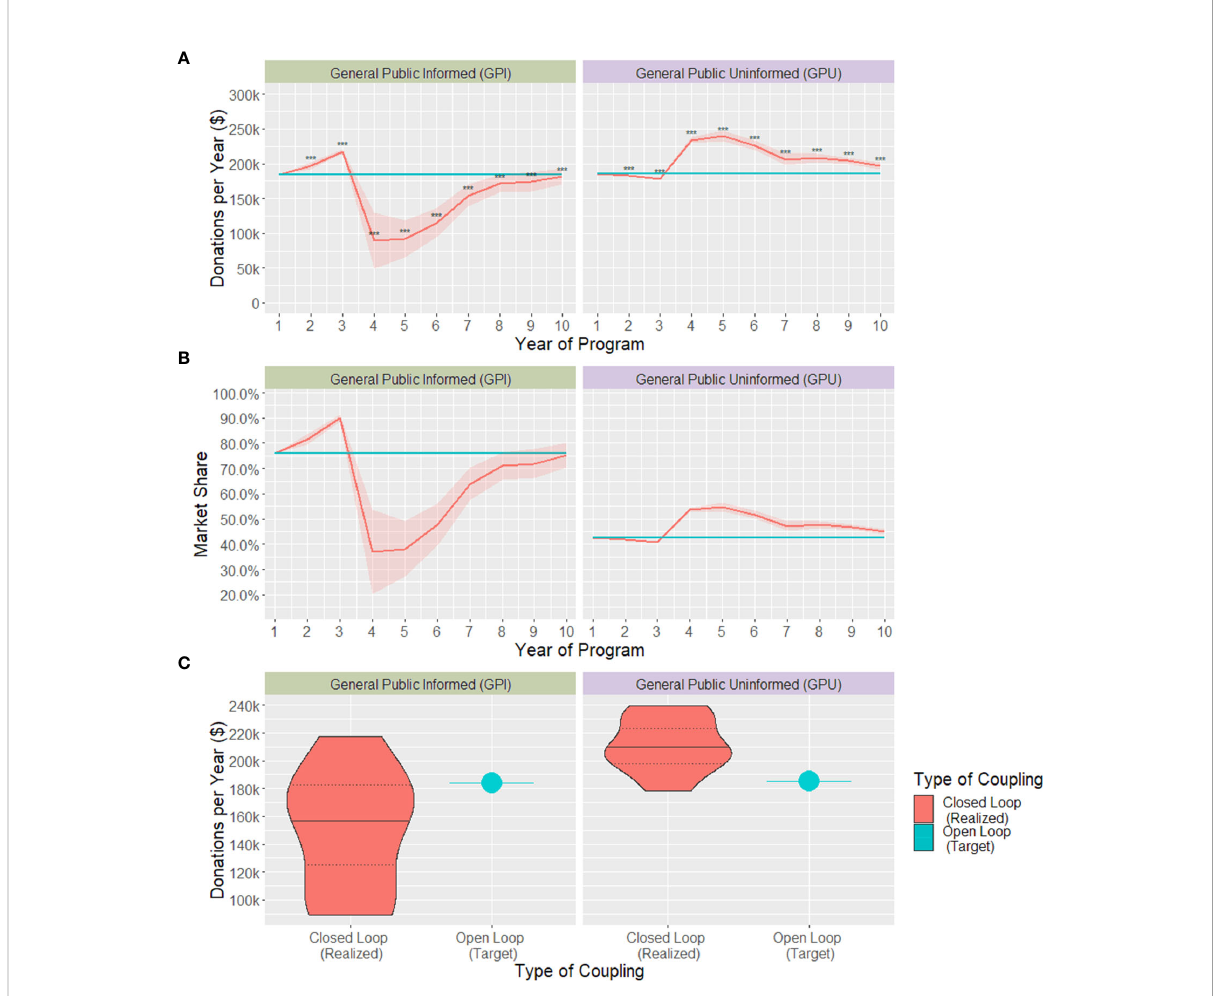
FIGURE 6 Donations. (A) Time series of target total donations using an open-loop coupling (teal) and realized donations received (salmon), as forecasted by the closed-loop coupling. (B) proportion of potential donors (market share) contributing in a speci fi c year as forecasted by an open-loop coupling (teal) compared to the market share realized participation modelled by the closed-loop coupling(salmon). (C) realized donations ’ posterior distribution (salmon) against the realized value (teal). ***1% signi fi cance level with two-tailed